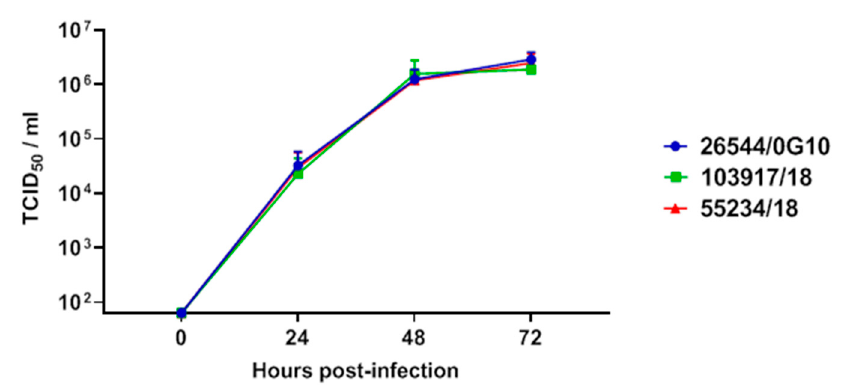
Figure 2. Growth kinetic in macrophages of the two ASFV strains collected from illegal free-ranging pigs. moM Φ were infected with the strains under study (103917/14 or 55234/18) or the virulent 26544/OG10 ASFV strains using a multiplicity of infection (MOI) of 0.01. At 0, 24, 48, and 72 h pi, duplicate samples were collected, and infectious viral progeny in culture supernatants were assessed by titration (TCID 50 /mL). The sensitivity of this assay was 1.8 log 10 50% haemadsorbing doses/mL (TCID 50 /mL). The mean values and the standard deviation from three independent experiments utilizing different animals are shown. At each time-point, values of 103917/14 and 55234/18 and 26544/OG10 viral titres were compared using the analysis of variance (ANOVA) for repeated measures.